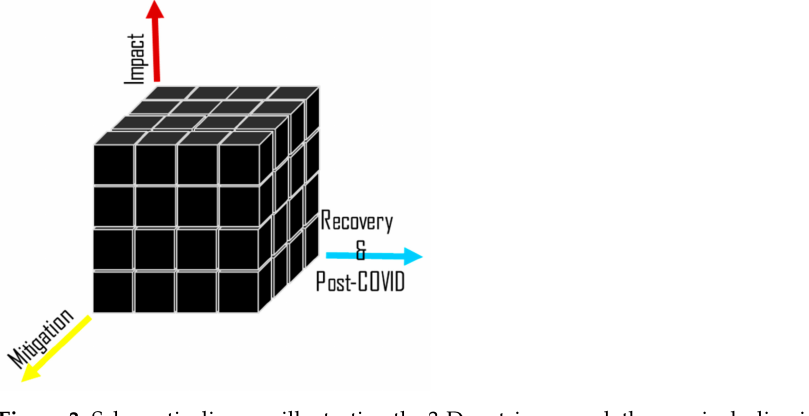
Figure 3. Schematic diagram illustrating the 3-D matrix research themes, including impact, mitigation, and recoverability.